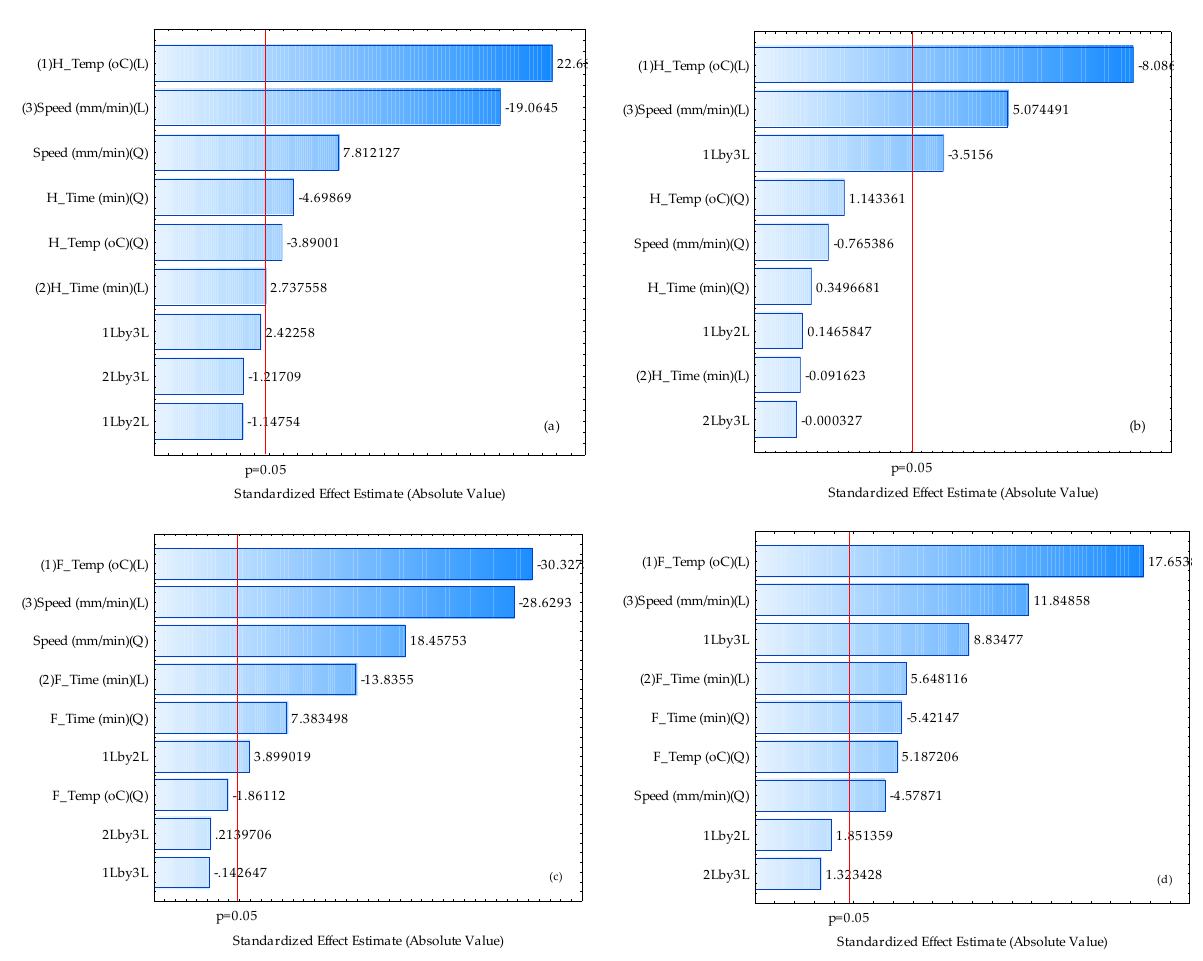
Figure 4. Pareto chart of standardized effects of the factors and interactions for O Y : oil yield (%) and V OE , volume of oil energy under heating temperatures ( a , b ); and freezing temperatures ( c , d ); temperature; F_Time: F TM , freezing time; Q: quadratic; and L: